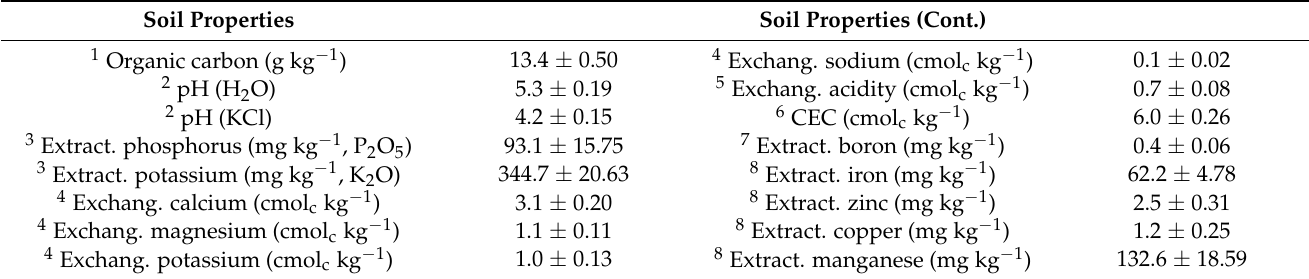
Table 1. Selected soil properties (average ± standard deviation, n = 3) from composite samples (10 cores per composite sample) taken at 0–0.20 m depth at the beginning of the study. Soil Properties (Cont.)